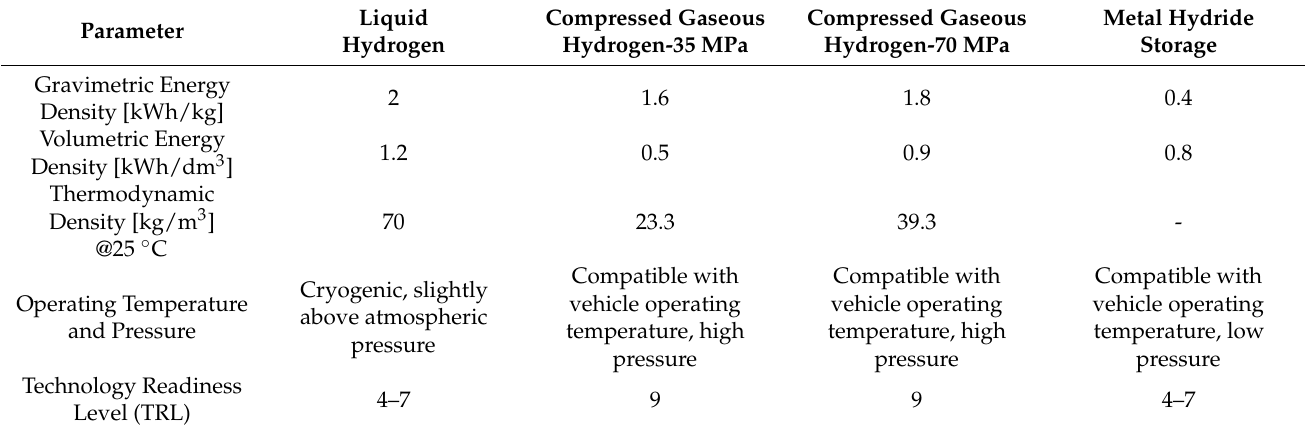
Table 1. Main characteristics of Hydrogen Storage